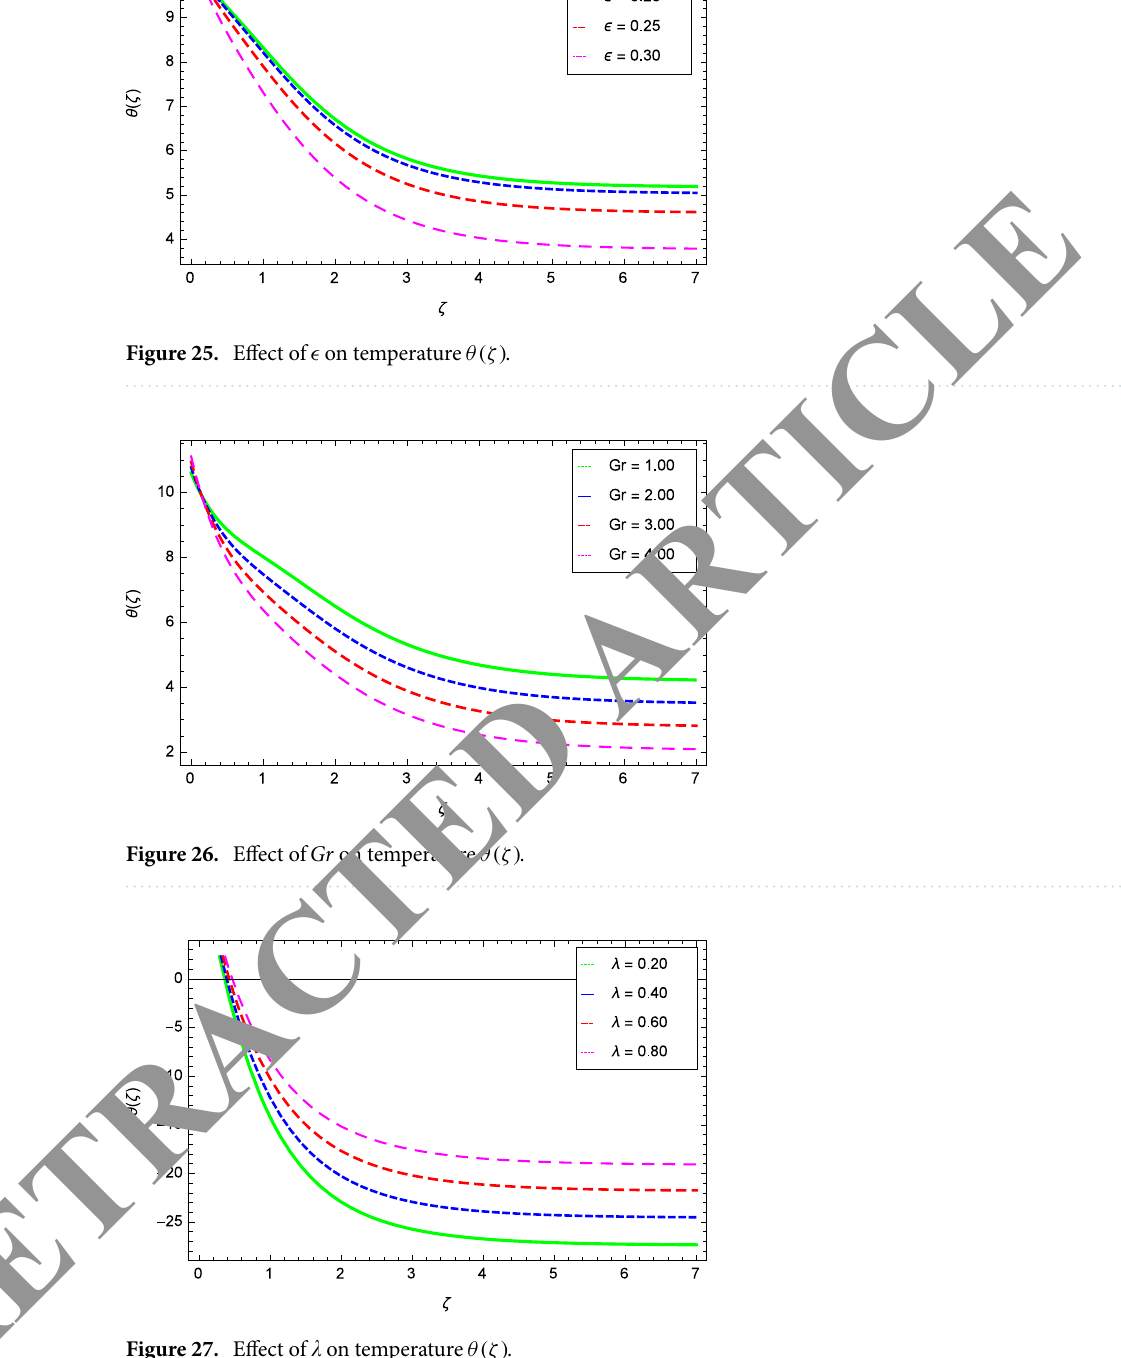
Figure 27. Effect of (cid:31) on temperature θ(ζ) .